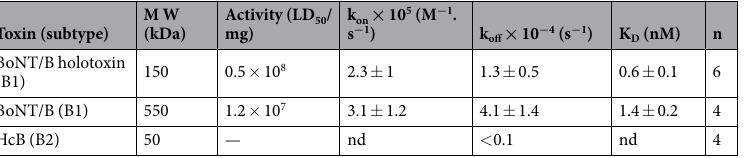
Table 1. Affinity constants of BoNT/B and HcB for exoSYT2/GT1b. n = independent experiments; nd = not determined; Values are mean ±